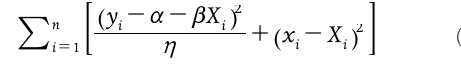
Figure 5. Plot of the obtained GOR relationship between M (black line). Grey boxes indicate M M D son, SLR, ISR, Murru et al. [2007] and D’Amico and Maiolino [2005], are also plotted. Dashed lines indicate data outside the range of definition of the